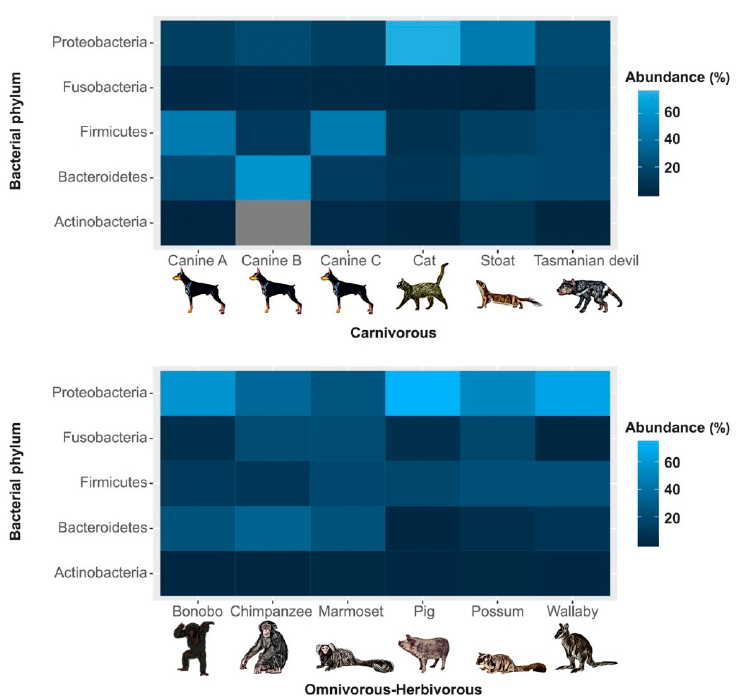
Figure 3. Major components of the oral bacterial communities of a selected number of carnivorous (top) andomnivorous-herbivorous (bottom) mammals. Colour intensities indicate the percentage abundance of five major bacterial phyla.